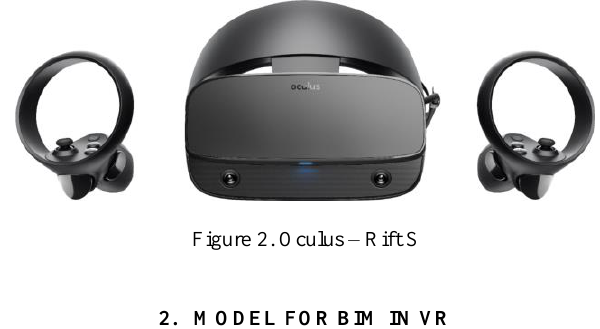
Figure 2. Oculus – Rift S